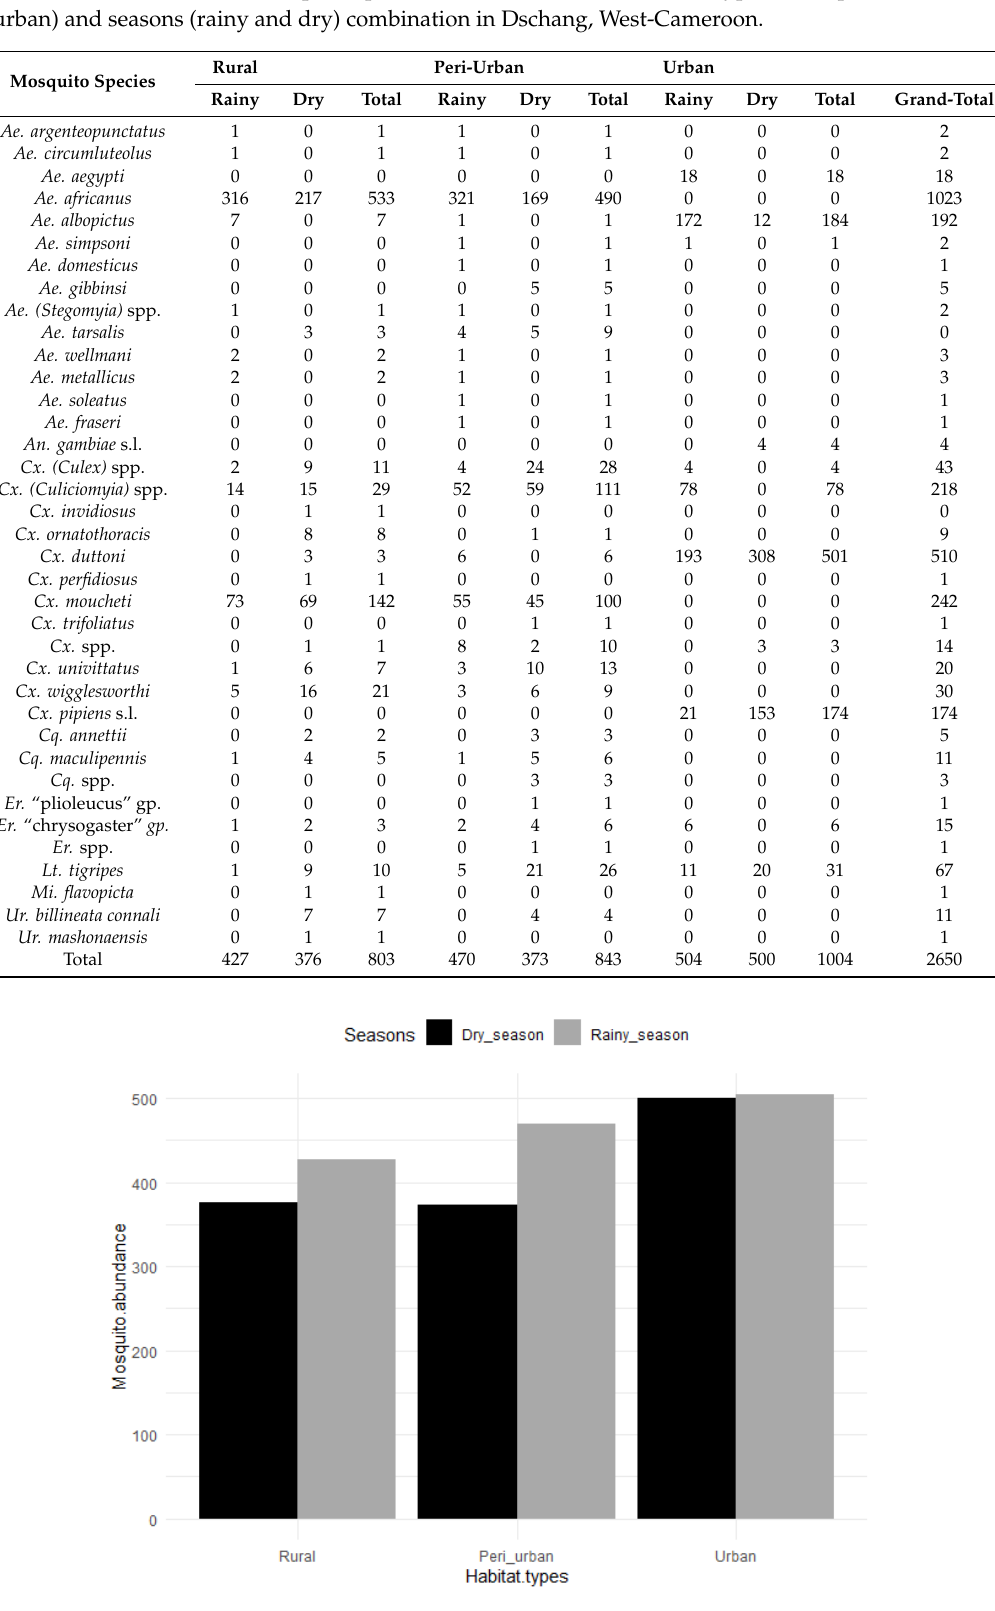
Figure 3. Mosquito abundance across habitats and seasons in Dschang, West-Cameroon.